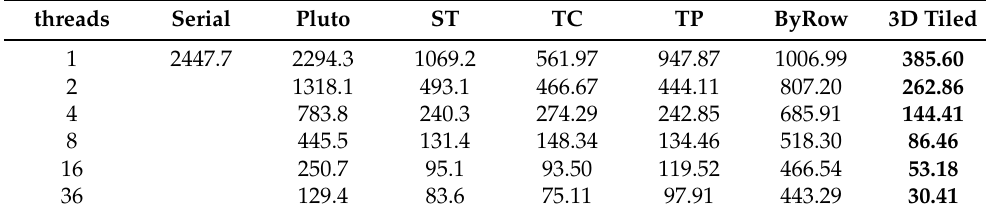
Figure 4. Speedup for Intel Xeon E5-2699 v3 and 36 threads. Table 6. Time in seconds for Intel Xeon E5-2699 v3 and RNA sequence length, N = 10,000 (ST is space time, TC is tile correction, TP is